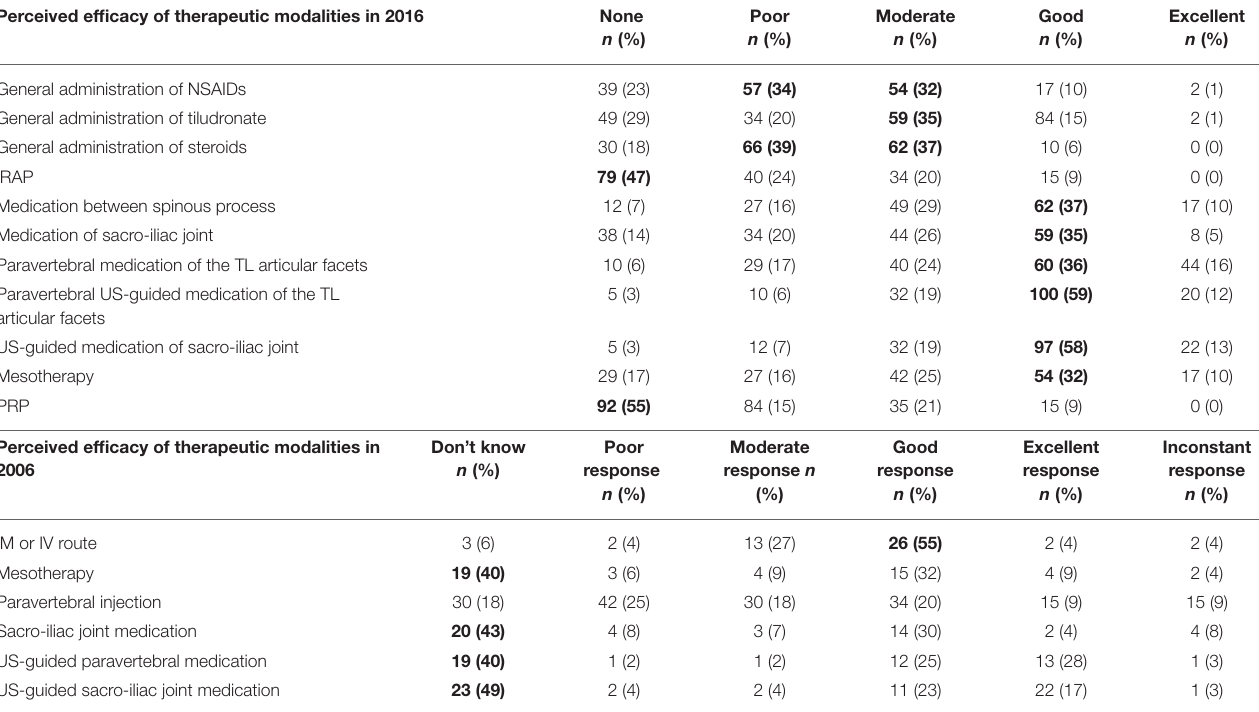
TABLE 7 | Perceived efficacy of different therapeutic modalities to treat back-pain in horses by 2006 and 2016 survey respondents. Perceived efficacy of therapeutic modalities in